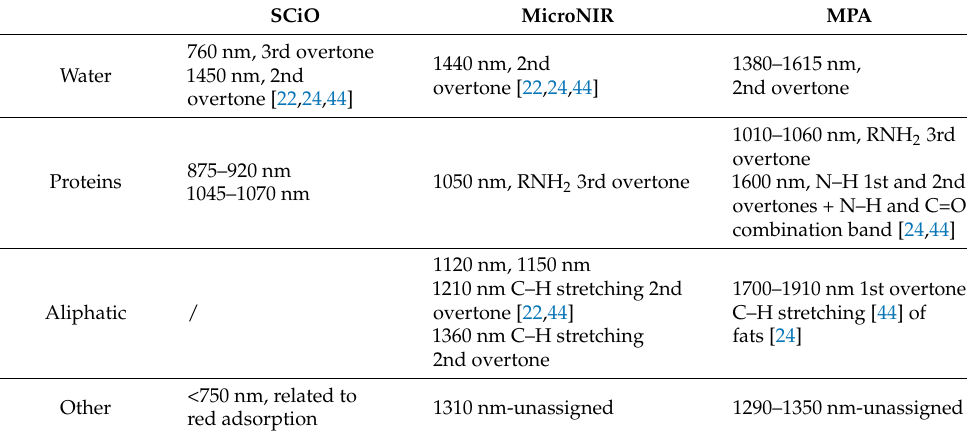
Table 3. Signal assignments of the most influential variables identified using the VIP scores of the PLS–DA models.